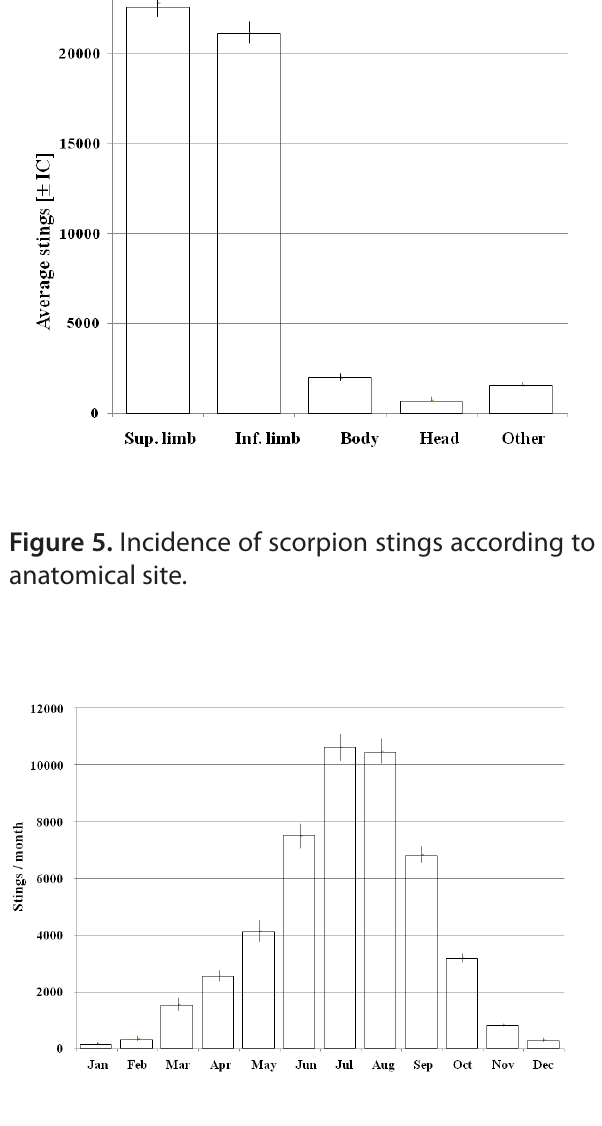
Figure 6. Seasonal incidence of scorpion